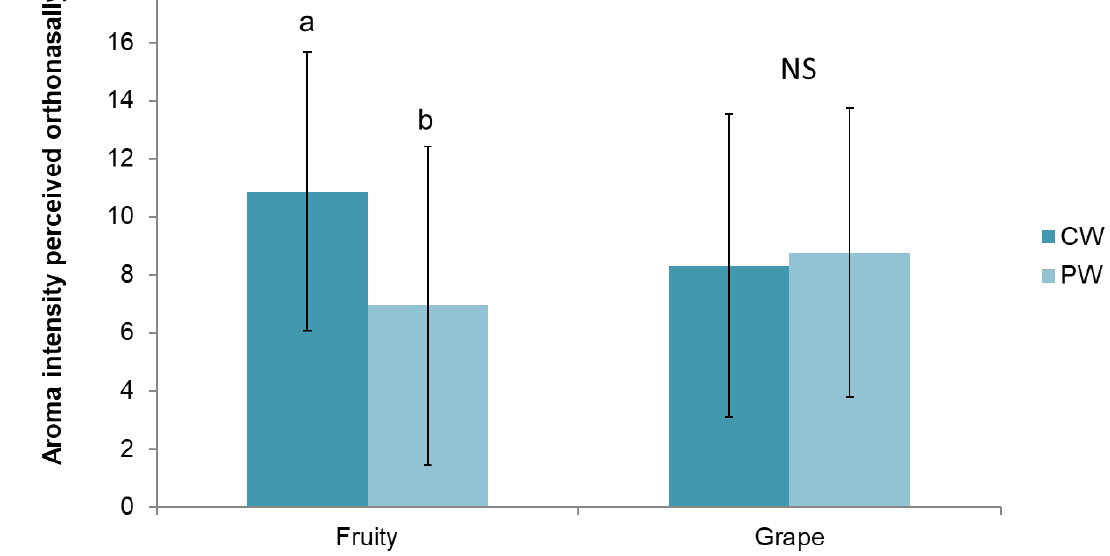
Figure 3. Intensity scores of the aroma descriptors determined orthonasally by the trained panel ( n = 10) in the control wine (CW) and in the wine supplemented with the GSE (PW). Different letters across the different time points indicate significant differences between wines ( p < 0.05, α < 0.05); NS: no significant differences between wines ( p > 0.05).